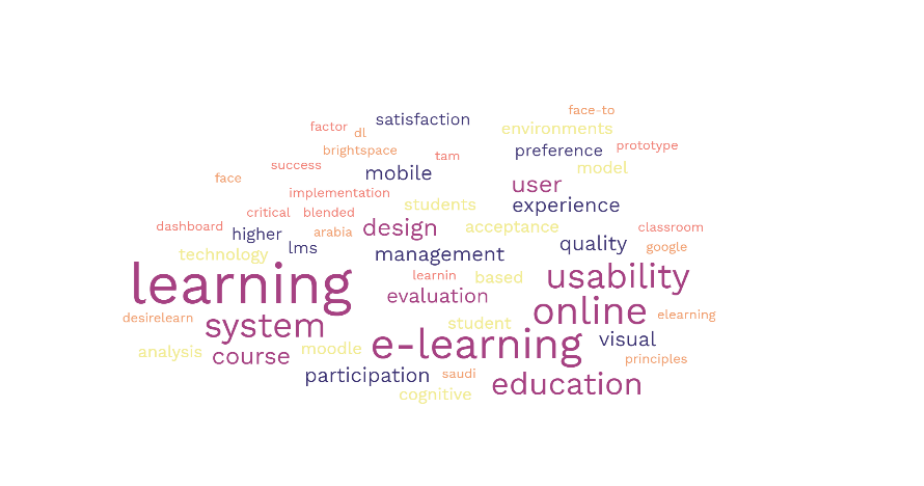
Figure 4: Word cloud of